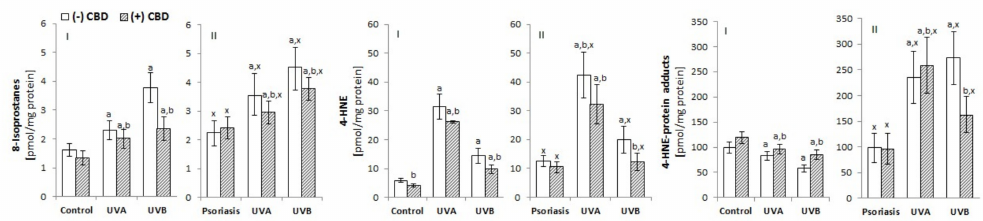
Figure 4. The e ff ect of CBD (4 µ M) on lipid peroxidation products, such as 8-isoprostanes and 4-HNE, as well as 4-HNE-protein adduct levels in keratinocytes exposed to UVA (30 J / cm 2 ) and UVB (60 mJ / cm 2 ) radiation. The keratinocytes were obtained from healthy subjects ( I ) (n = 15) and patients with psoriasis vulgaris ( II ) (n = 30). The mean values ± SD are presented with statistically significant di ff erences: a -vs. control / psoriasis group; b -vs. group without CBD; x -psoriasis vs. control group; p <